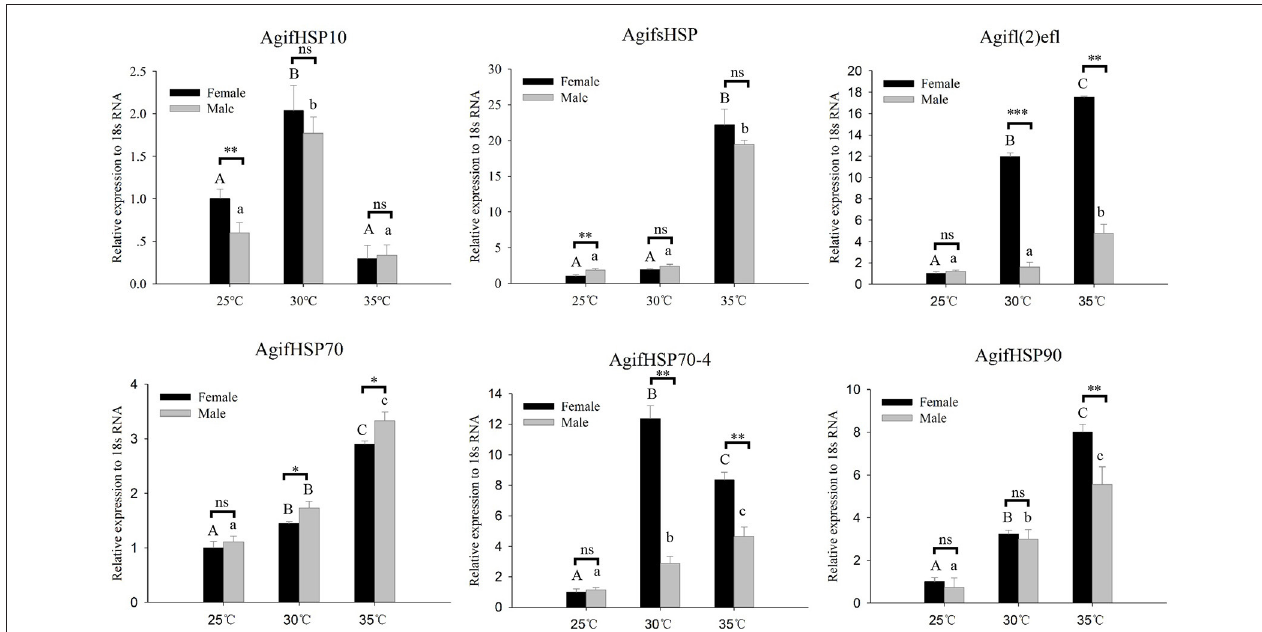
FIGURE 3 | Relative expression of A. gifuensis HSPs under the short-term thermal treatment. Different letters over the bars designate a significant difference at P < 0.05. And “*” means P < 0.05, “**” means P < 0.01, “***” means P < 0.001.